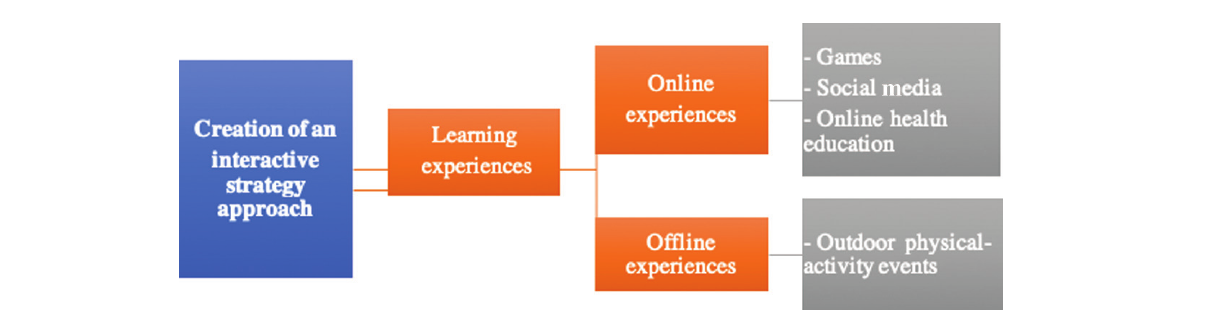
Figure 4. Creation of an interactive strategy for ACTIVITAL (Source: Authors,